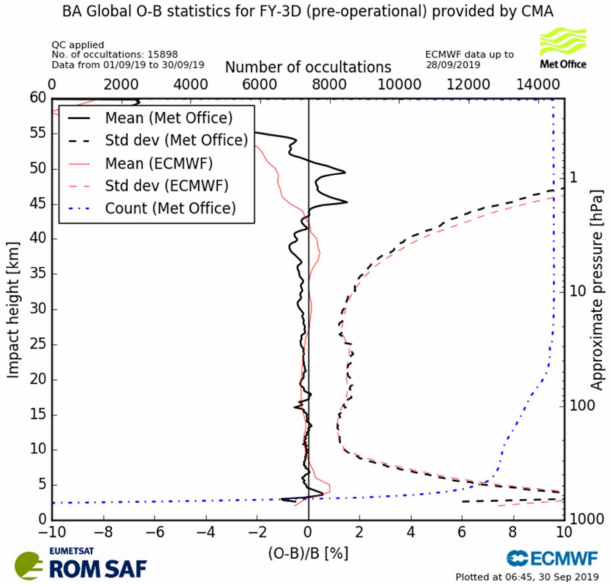
Figure A2. Monthly O-B statistics of FY3D, September 2019. The mean relative difference (RD) between ECMWF forecast and FY3D is less than 2%. Copyright © 2022 EUMETSAT.